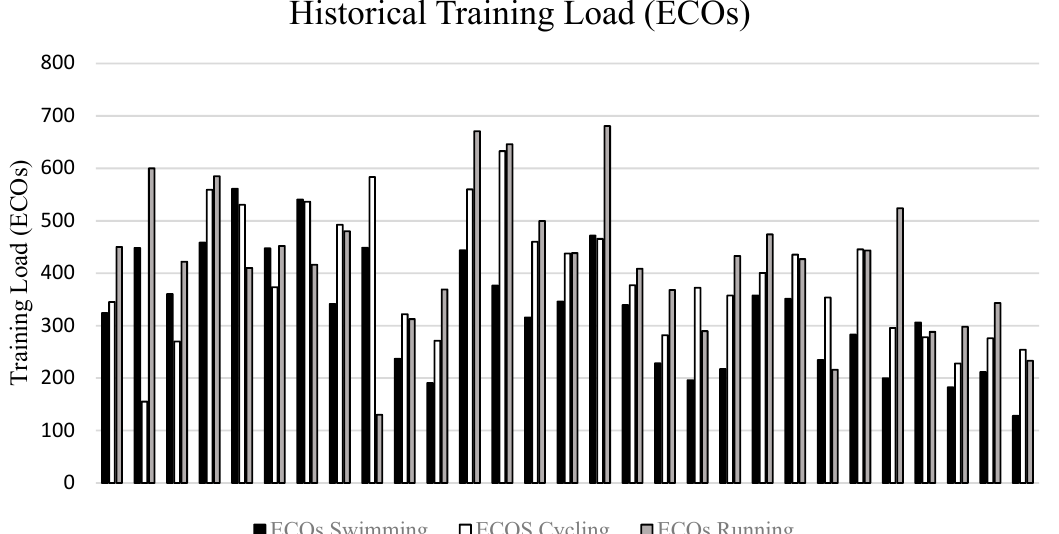
Figure 1. Historical objective load scale (ECOs) training load in the disciplines of swimming, cycling and running performed by the triathletes during the season.